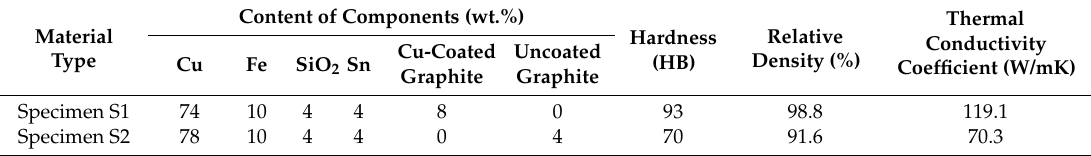
Figure 2. SEM photographs of Cu-coated graphite ( a ) and uncoated graphite ( b ). Table 1. Chemical composition and properties of the two specimens.